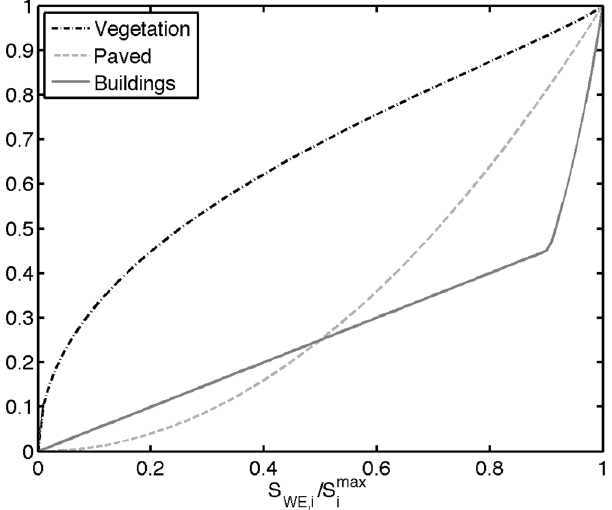
Figure B1. Surface snow fraction depletion curves for vegetated, paved and building surfaces. The paved and building curves were obtained from Valeo and Ho (2004), whereas the vegetation curve was obtained by fitting Swenson and Lawrence (2012) to Ek et al. (2003)